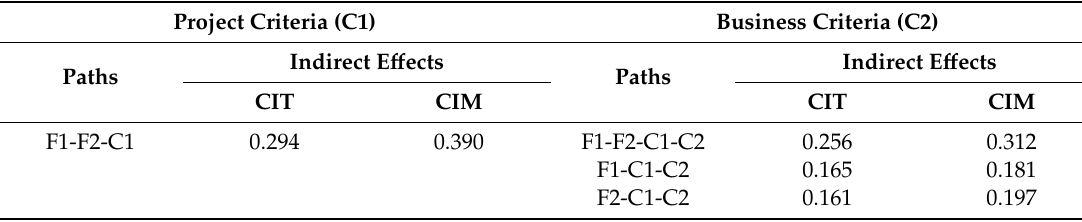
Table 21. Indirect e ff ects